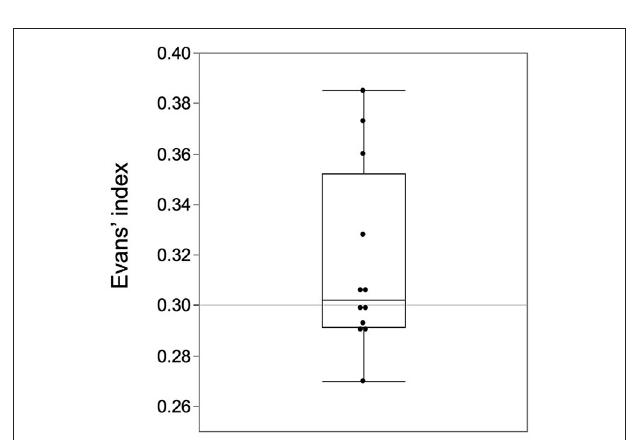
FIGURE 6 | Half of the early cases had an Evans’ Index of < 0.3. The Evans index of 0.3 or higher in the guidelines should be revised for early-stage cases.